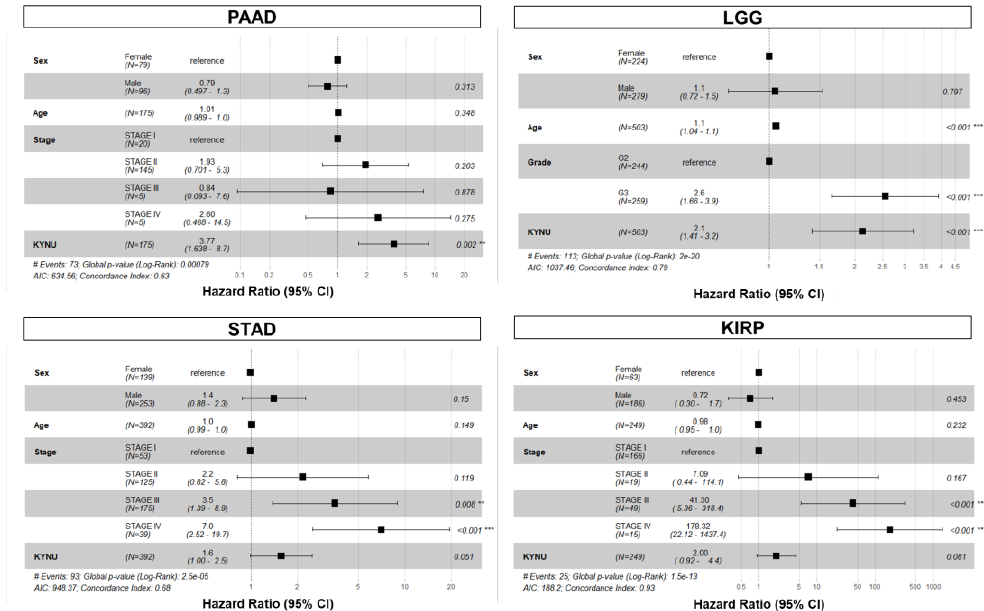
Figure 4. Forest plots depicting hazard ratios (HR) and 95% confidence intervals for pertinent clinical variables and tumoral KYNU mRNA levels (por log 10 unit increase) for overall survival in low-grade glioma (LGG), kidney renal papillary cell carcinoma (KIRP), stomach adenocarcinoma (STAD), and pancreatic adenocarcinoma (PDAC) TCGA datasets.